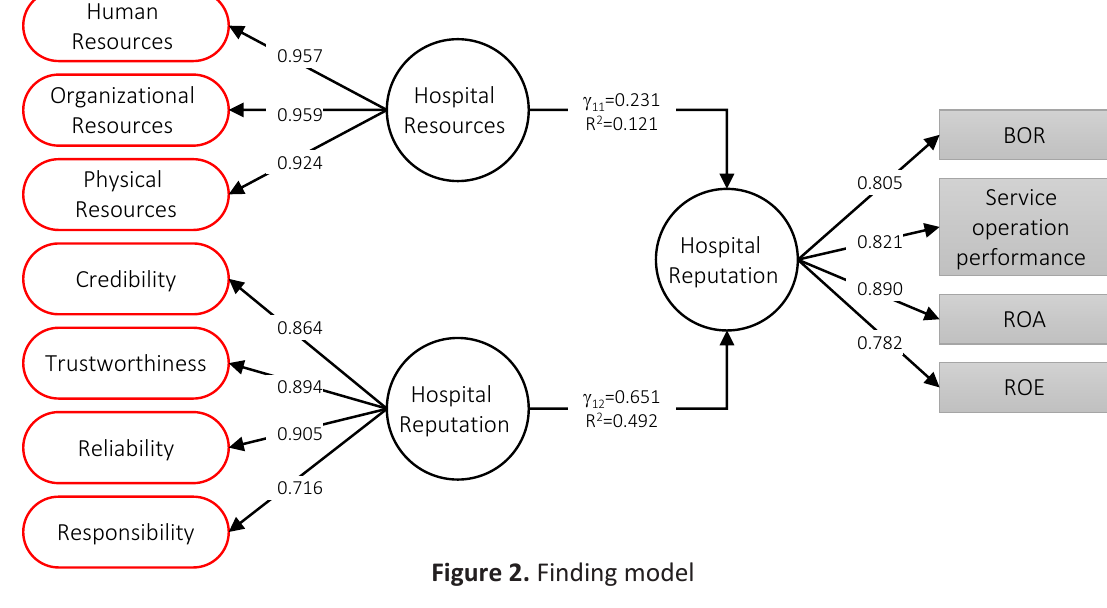
Figure 2. Finding